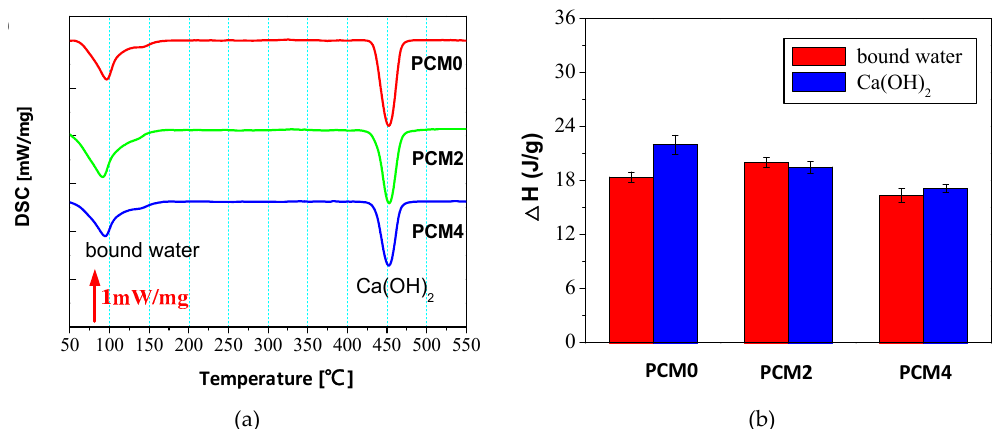
Figure 9. Di ff erential scanning calorimetry (DSC) analysis of cement mortars at 28 days. ( a ) DSC curves Figure 9. Differential scanning calorimetry ( DSC) analysis of cement mortars at 28 days. ( a ) DSC and ( b ) bound water and Ca(OH) 2 content. curves and ( b ) bound water and Ca(OH) 2 content.